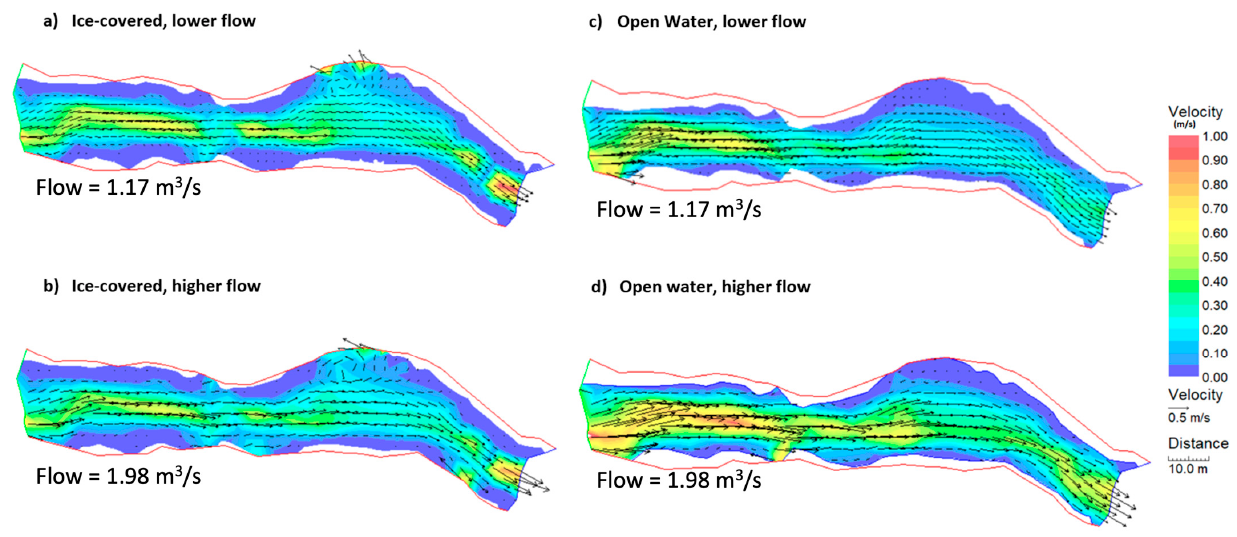
Figure 5. Modeled depth-averaged velocities during ( a ) ice cover, lower flow conditions (1.17 m 3 /s); ( b ) ice cover, higher flow conditions (1.98 m 3 /s); ( c ) open-water, lower flow conditions (1.17m 3 /s); and ( d ) open water, higher flow (1.98 m 3 /s). Flow directions are indicated at 1 m intervals using vector arrows (if they were plotted at 0.1 m intervals it would be difficult to visualize), and no-flow boundaries are outlined in red; the inflow boundary is on the left and outflow boundary on the right. Prepared in River2D.